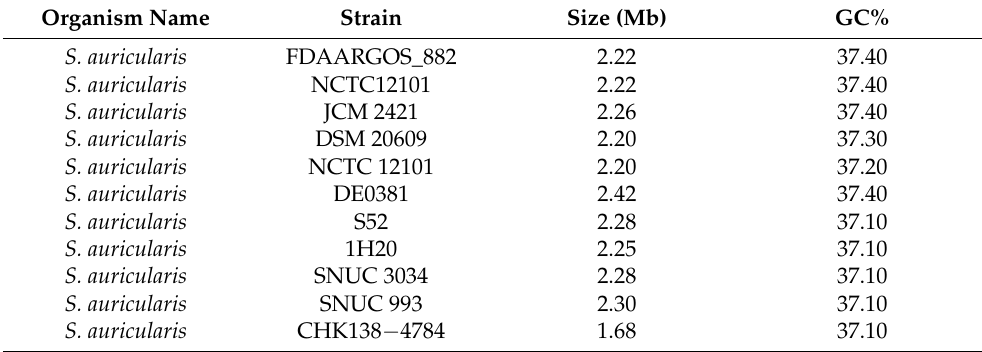
Table 1. S. auricularis strains with different statistics.